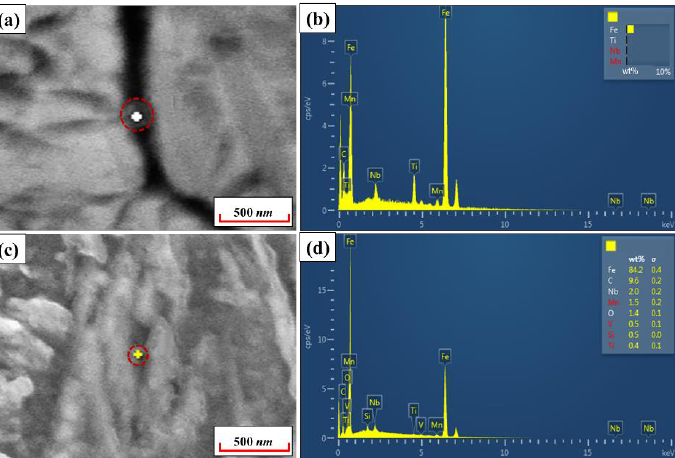
Figure 18. EDS analysis of grain boundaries and intragranular precipitates in 22MnB5NbV steel: ( a ) and ( b ) are for the grain boundaries; ( c ) and ( d ) are for the grain intragranular.